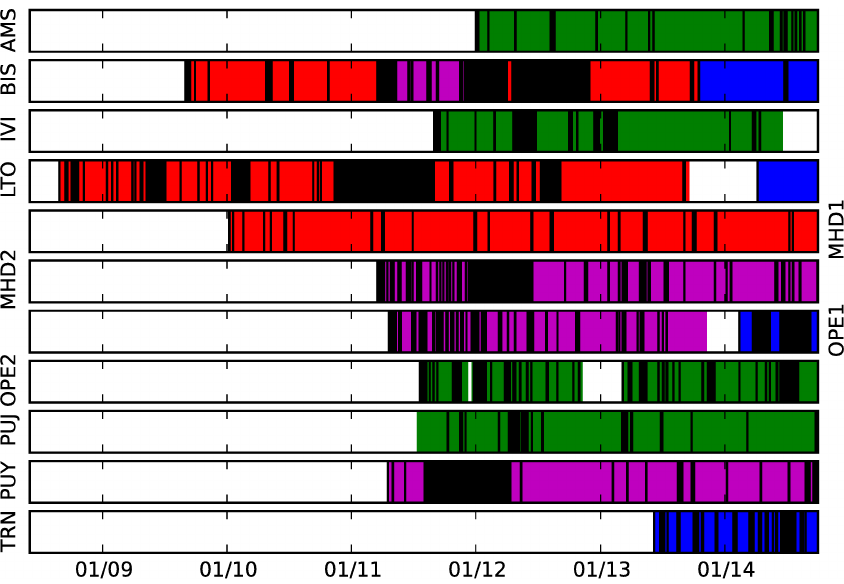
Figure 10. Daily average of data availability at each site (if 50% of data are valid for 1 day, then the day is valid; if less, the day is invalid). Valid data are in color; invalid data are in black (% are indicated in Table 1). ESP1000 are in red, G1301 in magenta, G2301 in green and G2401 in